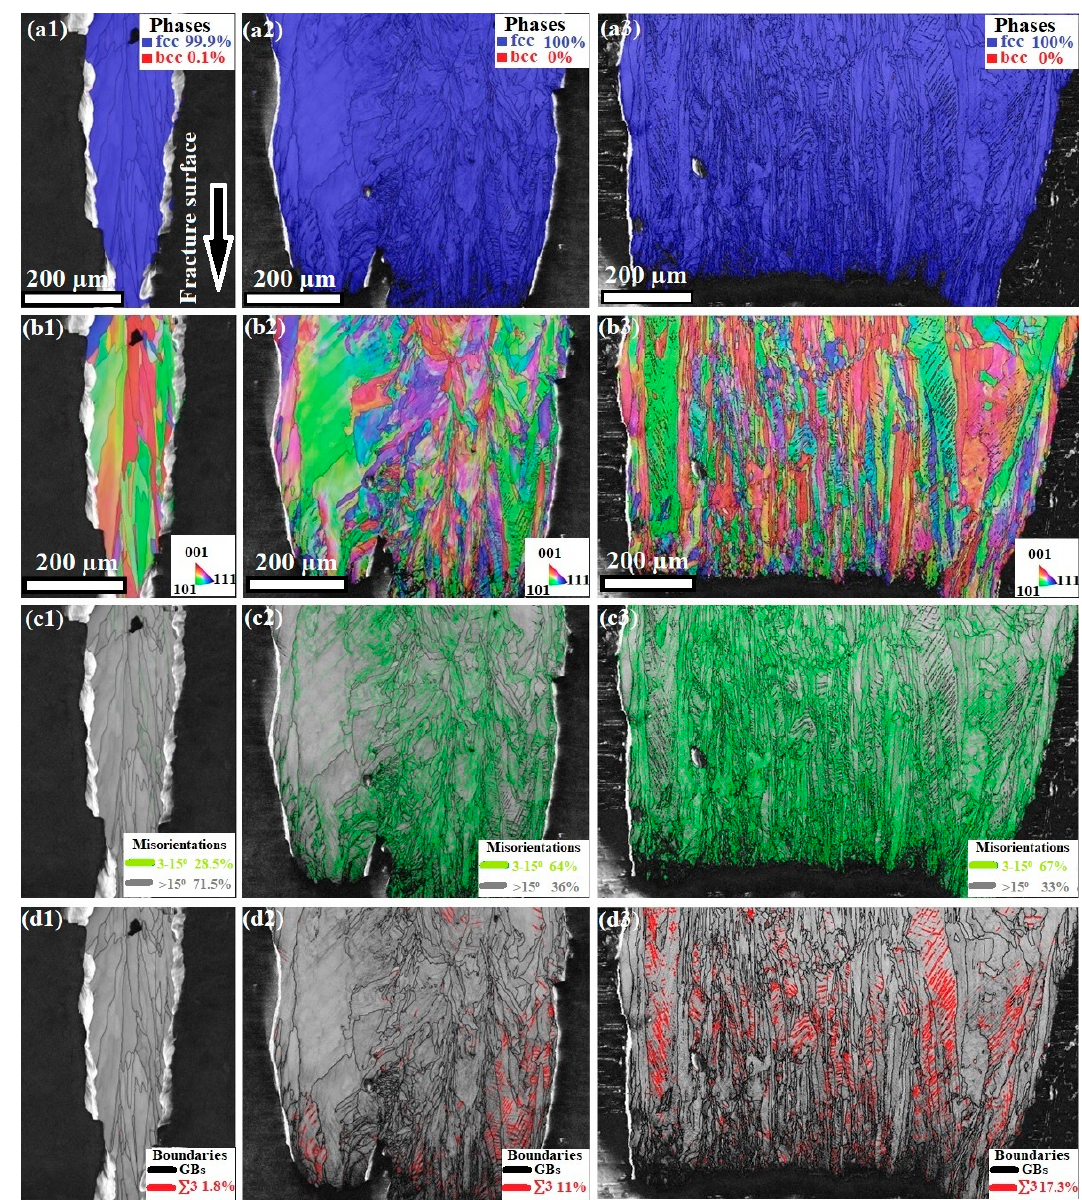
Figure 8. EBSD maps of H-charged microstructures of auxetic 316L-SS with various thicknesses: T0.6 ( 1 ), T1 ( 2 ), and T1.4 ( 3 ). ( a ) Phase maps showing ( γ -FCC) in blue; ( b ) inverse pole figure (IPF) maps; ( c ) misorientation boundary maps showing LAGBs in green, and ( d ) boundary maps showing Σ 3 twin boundaries in red.